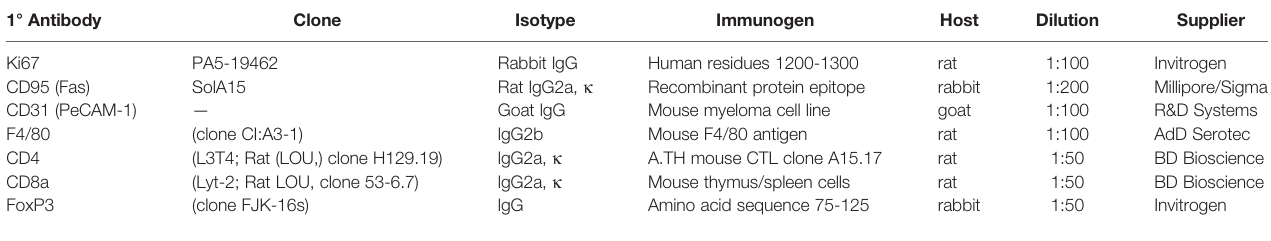
TABLE 1 | Primary antibodies for immunohistochemical staining in orthotopic RM-9 tumors. 1°